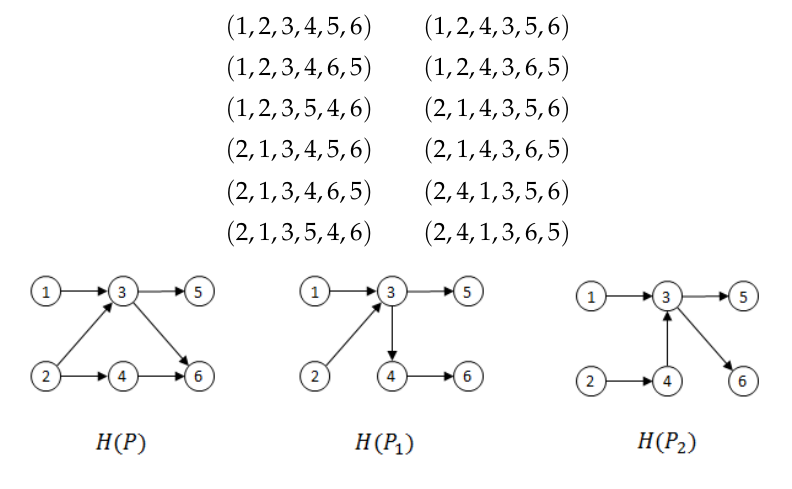
Figure 2. Example of Theorem